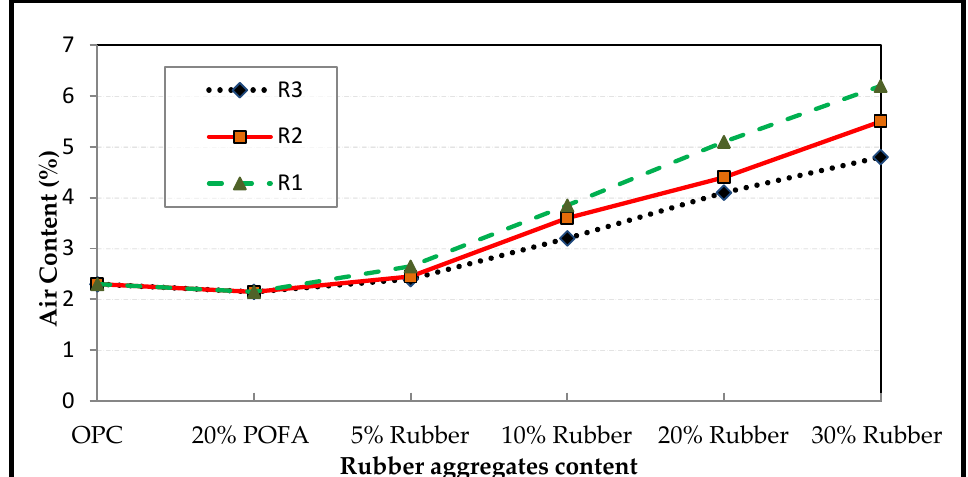
Figure 6. Effect of types and concentrations of TRAs on Air content.